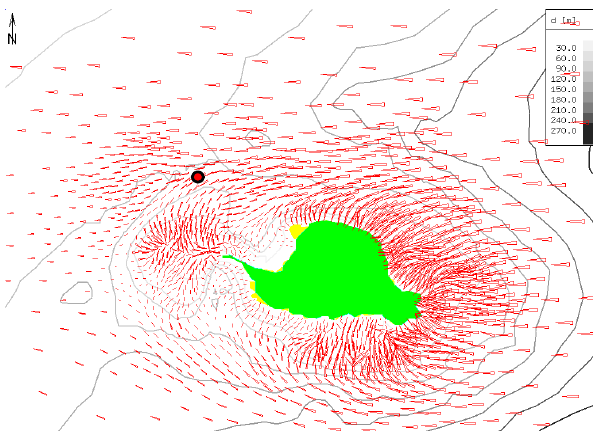
Fig. 8. Refraction characteristics in terms of mean wave direction obtained using WWMII during the measured peak wave height at Guishandao Island (red dot shows the buoy location).